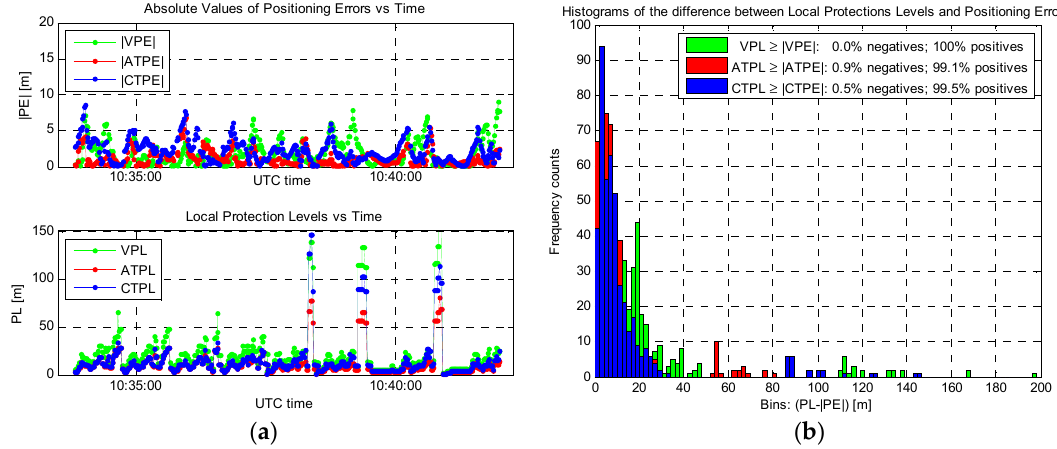
Figure 6. Results of the LPL analysis, assuming k AT = k CT = k V = 0.6: ( a ) Absolute positioning errors versus LPL values; ( b ) Conservativeness of LPL values versus positioning errors.